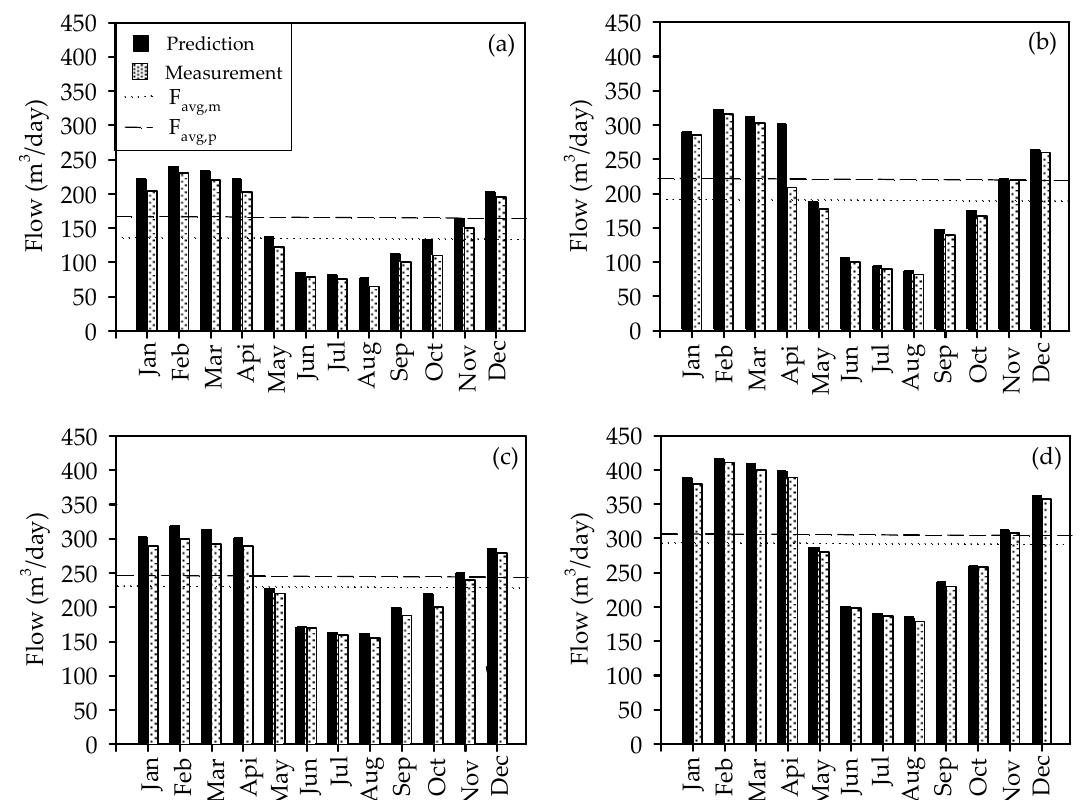
Figure 18. Monthly Predicted and measured water flow for Pongluek village without a tracker installed ( a ) and with a tracker ( b ) and Bangkloy village without a tracker installed ( c ) and with a tracker ( d ).